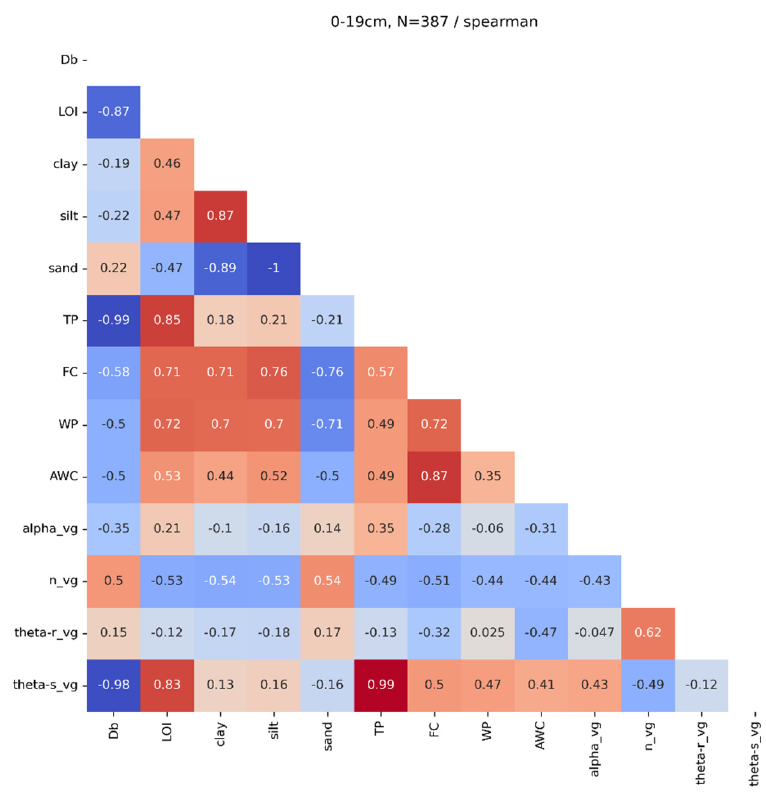
Figure 3. Correlation matrix between soil properties and hydraulic characteristics in the 0–19 cm layer. The values show bivariate Spearman rank correlation coefficients. The number of samples is 387, except for soil texture (clay, silt, sand) 144. For these sample sizes, the thresholds for statistically significant correlations ( p < 0.05) are ±0.09 and ±0.14, respectively.